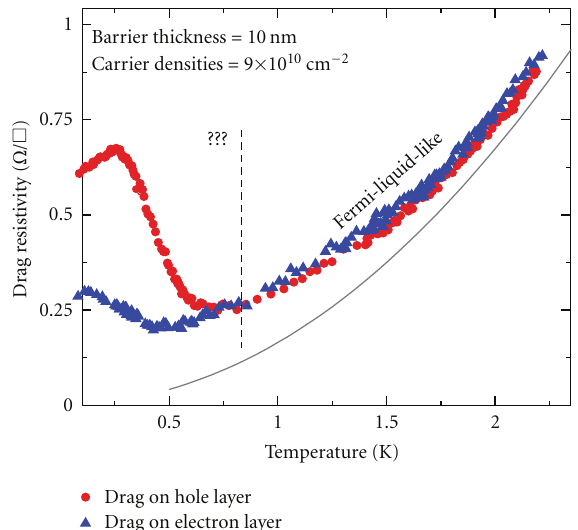
Figure 13: Electron (blue) and hole (red) drag resistivity versus temperature for n = p = 9 × 10 10 cm − 2 , down to 50 mK. The data of Figure 11 is reproduced along with the result of the calculation (solid line) described in the text. We considered a cosine wavefunction for the holes and a Fang-Howard type wavefunction for the electrons.